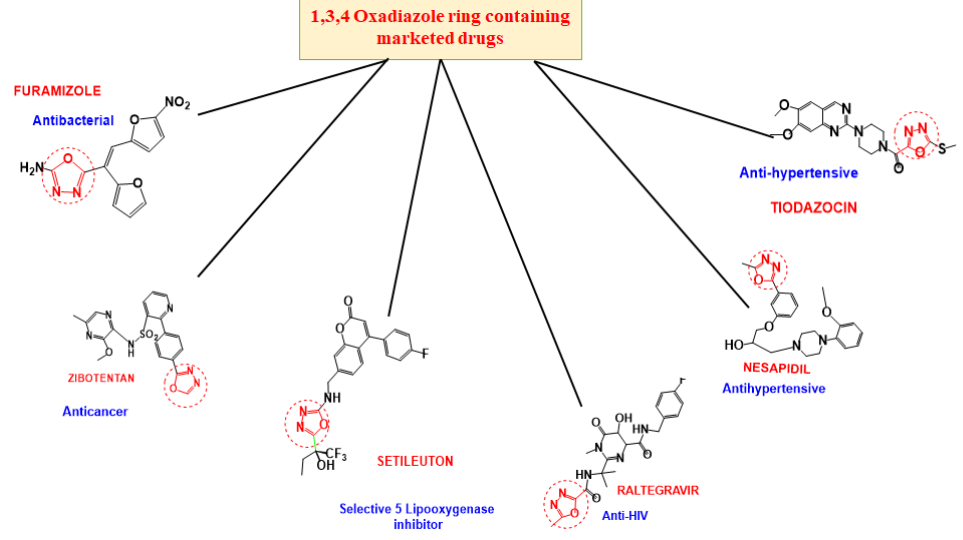
Figure 4. The commercial drugs of 1,3,4-oxadiazole ring.